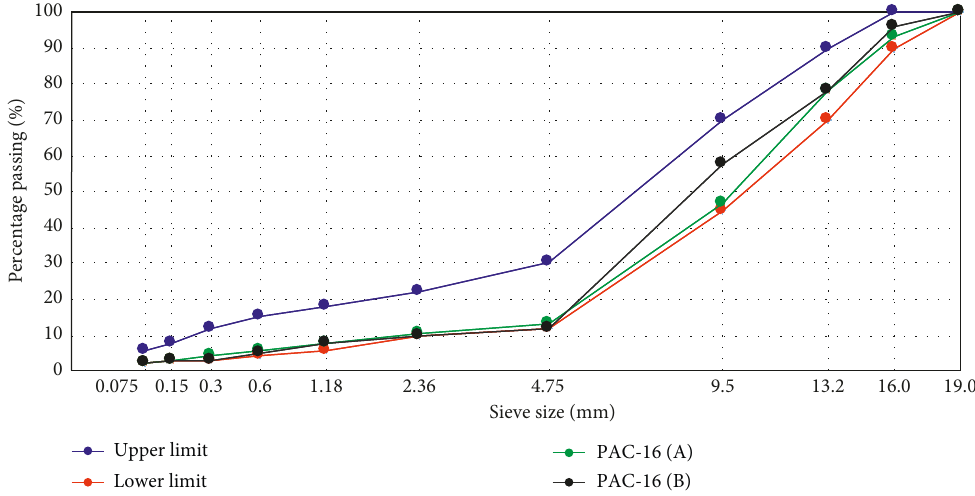
Figure 1: Aggregate gradations at two designed AV contents used for preparing PA specimens. Table 1: Main properties of asphalt, aggregate, filler, and fibre.